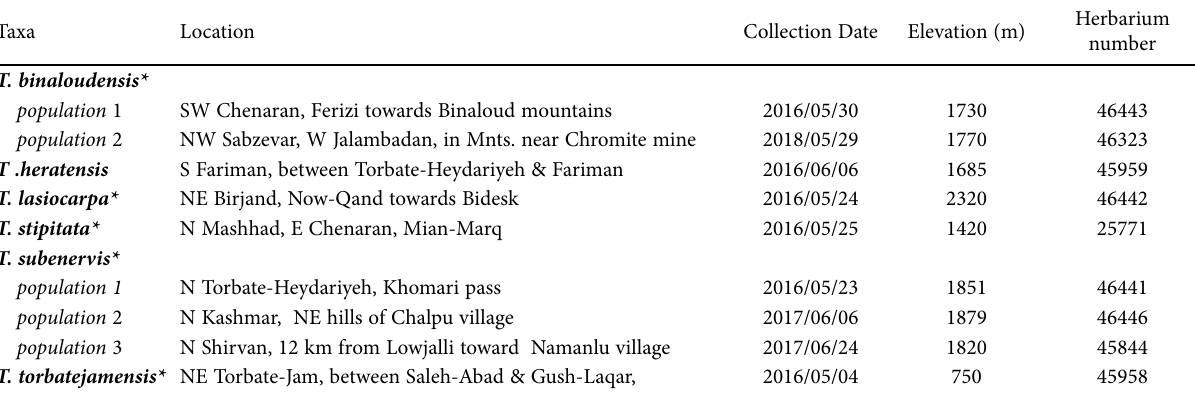
Table 1. Iranian endemic species of Trigonella analyzed in this study, their locations, and voucher specimens data.